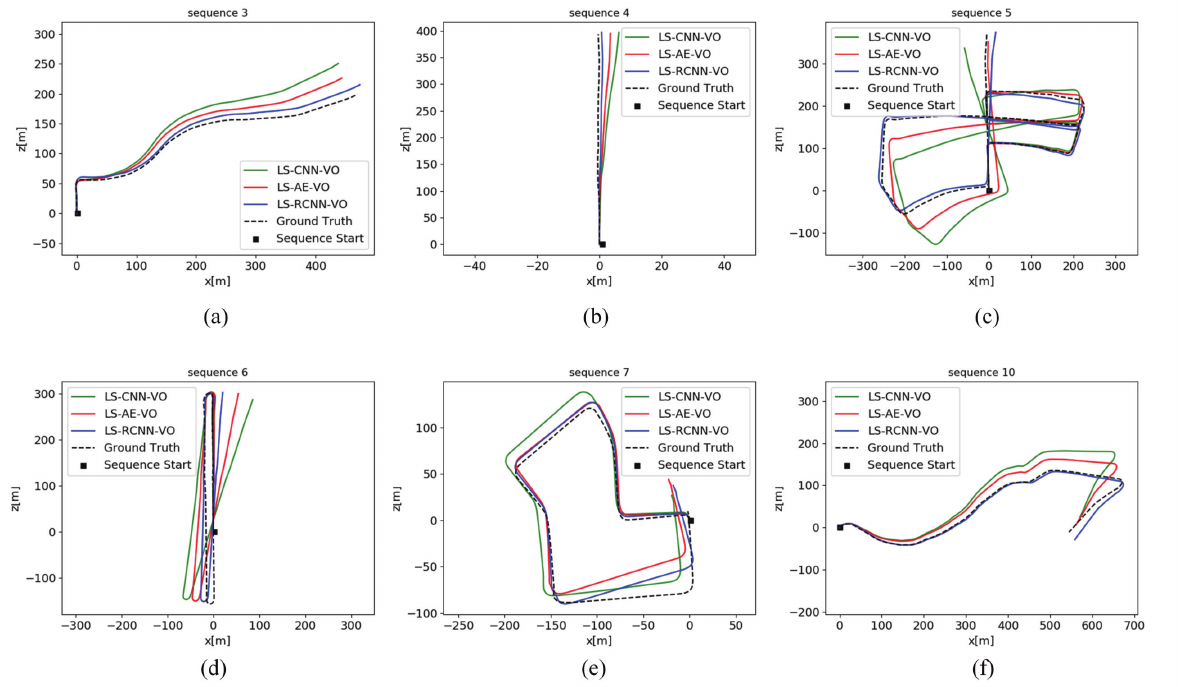
Figure 8. Comparison of the moving trajectories detected by the three models with the ground truth for sequence 03 ( a ), 04 ( b ), 05 ( c ), 06 ( d ), 07 ( e ), and 10 ( f ) of KITTI